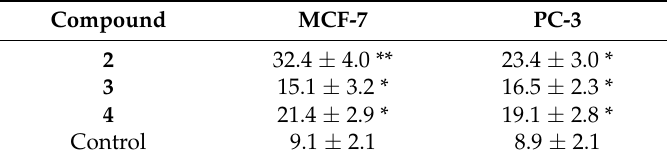
Table 4. Percentage of cells with caspases active on MCF-7 and PC-3-treated cells.